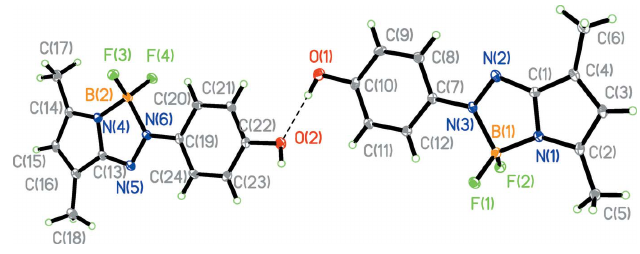
Figure 1 The asymmetric unit of the title compound, with displacement ellipsoids drawn at the 30% probability level. The O—H (cid:2)(cid:2)(cid:2) O hydrogen bond is shown as a dashed Table 1] and torsion angles [N2—N3—C7—C12 and N5—